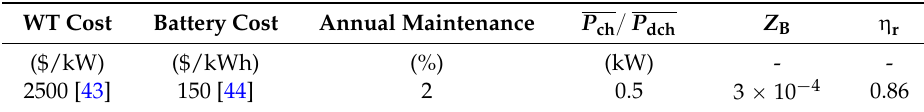
Table 1. Technical and economic data used in the optimization.